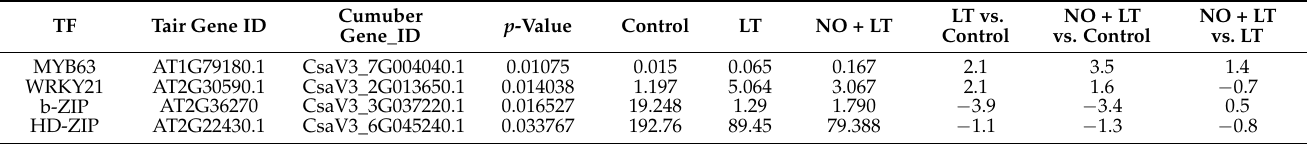
Table 2. The key DETFs in LT vs. Control, NO + LT vs. Control and NO + LT vs.